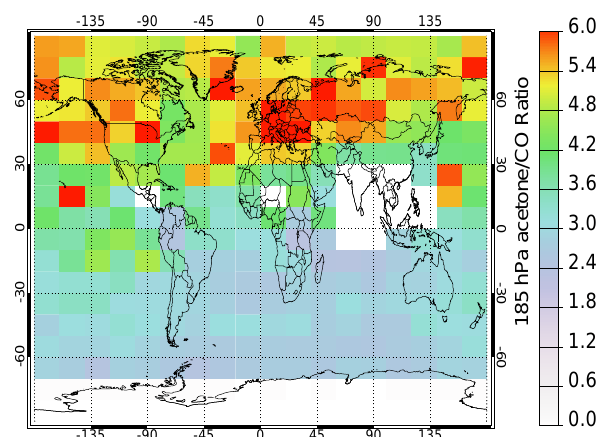
Fig. 13. 185hPa MORSE acetone/150hPa MOPITT CO ratio for